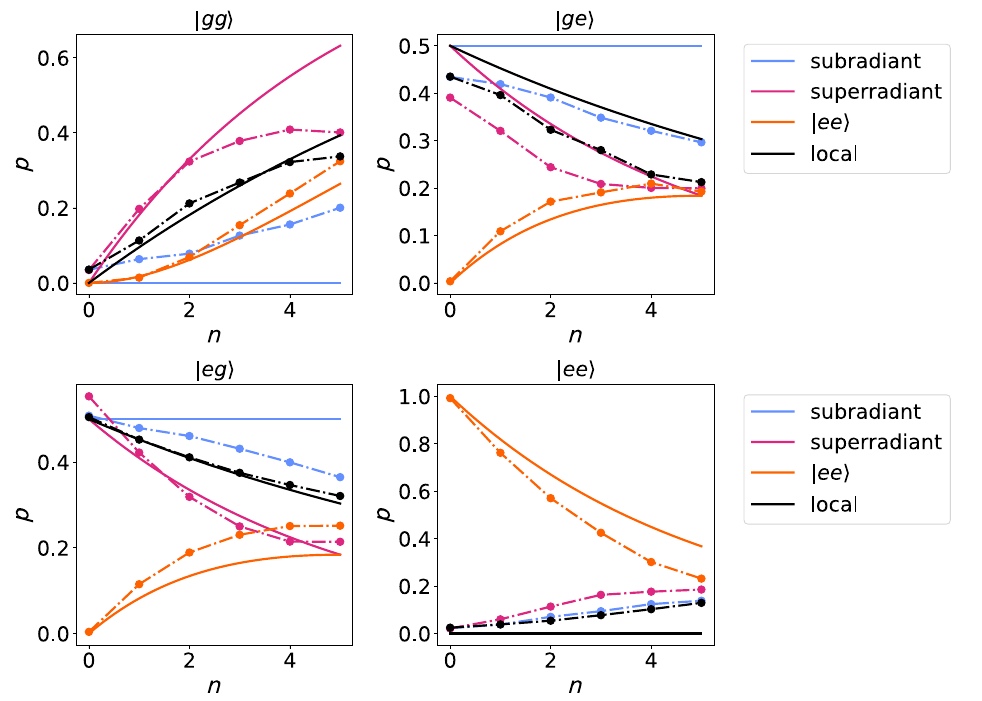
FIG. 2. The probability of finding the states | gg (cid:5) , | ge (cid:5) , | eg (cid:5) , and | ee (cid:5) through a projective measurement in the computational basis as a function of the number of steps in the MCM (first set of results), when the initial state is the subradiant state (light blue), the superradiant state (magenta), and | ee (cid:5) (orange), and when the dynamics are local, starting from the subradiant state (black). The continuous lines show the theoretical prediction based on the master equation, while the markers of the dash-dotted lines show experimental values. The results are obtained as averages over 37 realizations of the protocol and the error bars are within the